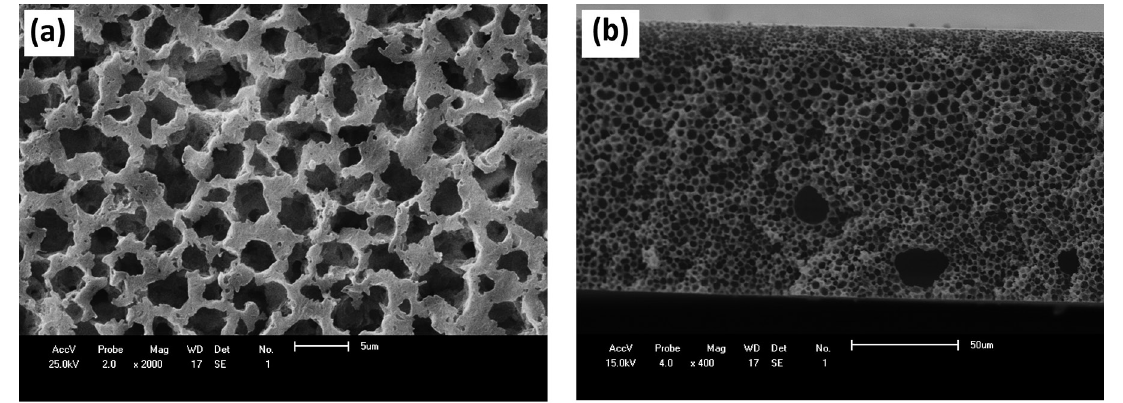
Figure 6. SEM images of PA6/5% MMT/CaCl